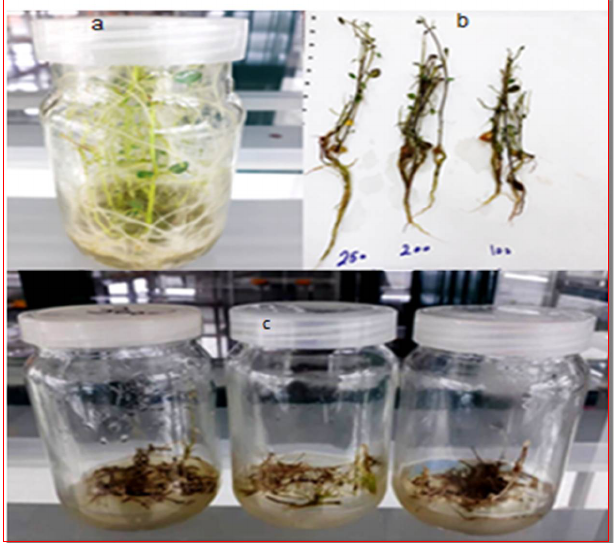
Figure 6. ( a ): In vitro rooted potato plantlets Spunta cv. ready for acclimatization stage in the greenhouse. ( b ): different length of roots with (CS-NPs) treatments. ( c ): high phytotoxicity and very low shoot regeneration as response to higher concentration of chitosan nanoparticles at (300 mg L - 1 ) on the explants in culture media. DAS-ELISA and RT-PCR results showed that (CS-NPs) produced high regeneration response with high frequencies of PVY-free plants. Electrophoresis of RT-PCR product showed an amplification of 825 bp DNA fragment in PVY-infected plants and no such amplification was obtained in PVY-free potato plantlets (Figure 7). For the confirmation of the virus, amplified band was extracted, sequenced, and analyzed. The sequence obtained had confirmed its homology with portion of coat protein gene of PVY. While indexing, eight samples of the tested negative plantlets in DAS-ELISA at the 100 mg L −1 (CS-NPs) were positive using RT-PCR. Plantlets which were tested negative in DAS- ELISA and RT-PCR were only considered virus free.